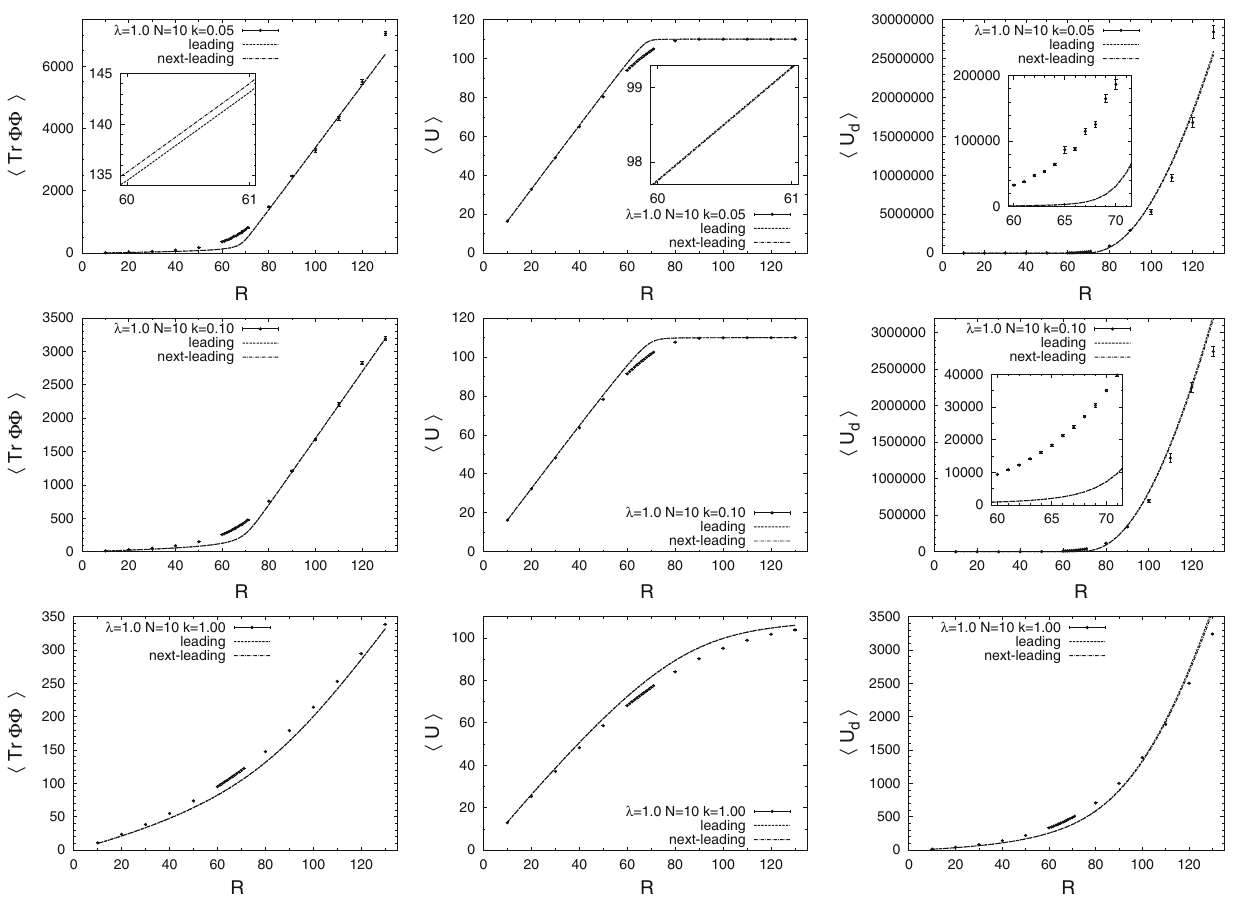
Fig. 5 λ = 1, N = 10 and k = 0 . 05 (top three), k = 0 . 10 (middle three) and k = 1 . 00 (bottom three) against R . The same notations are used,andsomesmallwindowsareputforthesamepurposesasinFig.3.